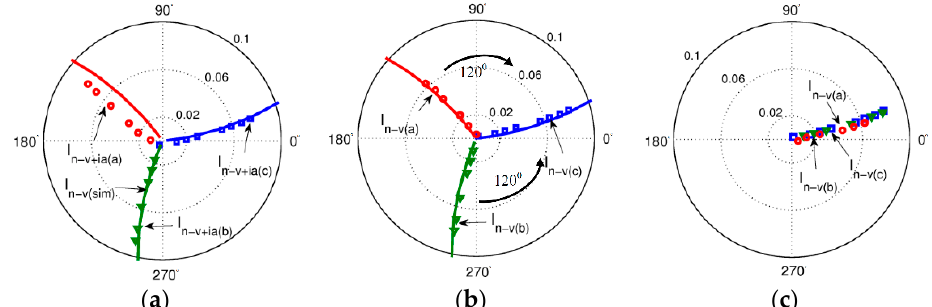
Figure 11. Three-phase phasor representation of the negative sequence current under a supply voltage unbalance: before ( a ) and after ( b ) inherent asymmetry compensation, and after 120° shift of two phases ( c ). The simulation results are shown by solid lines. The experimental results are indicated by symbols.